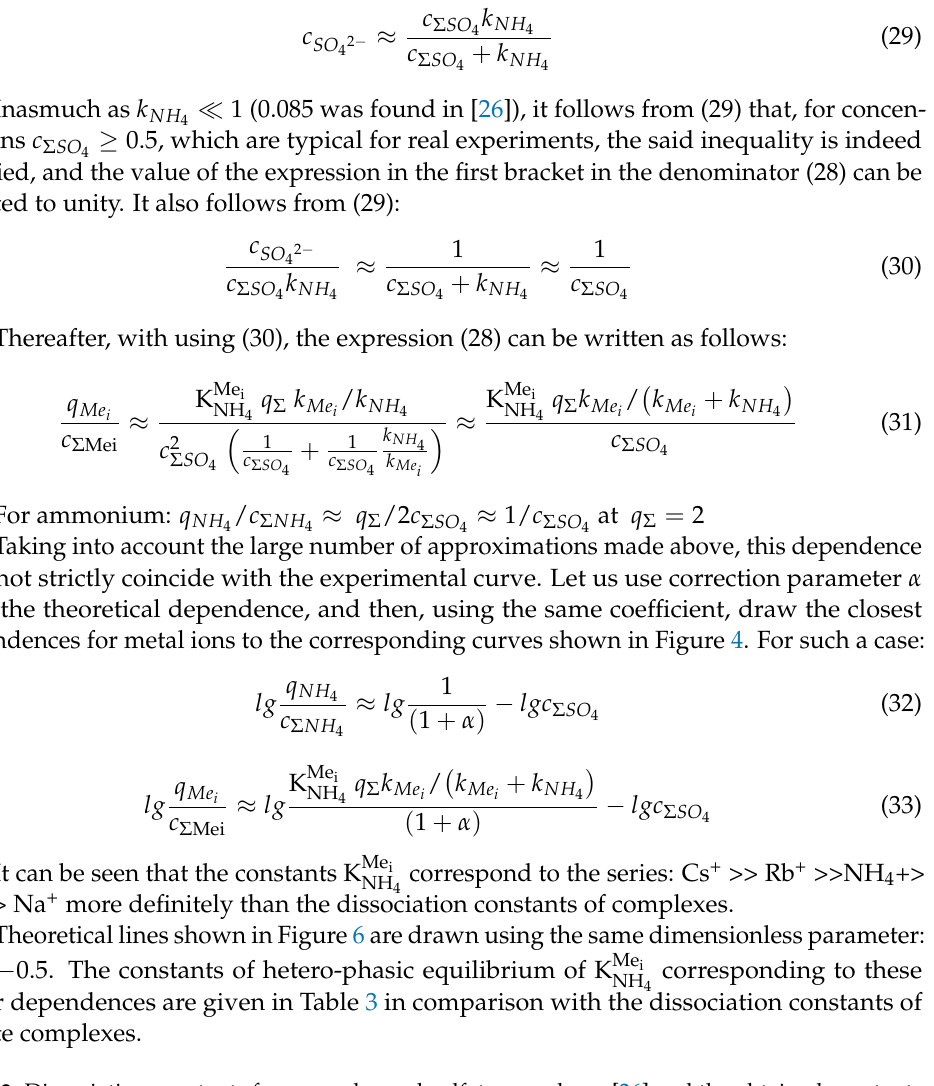
Table 3. Dissociation constants for monocharged sulfate complexes [26] and the obtained constants of hetero-phasic